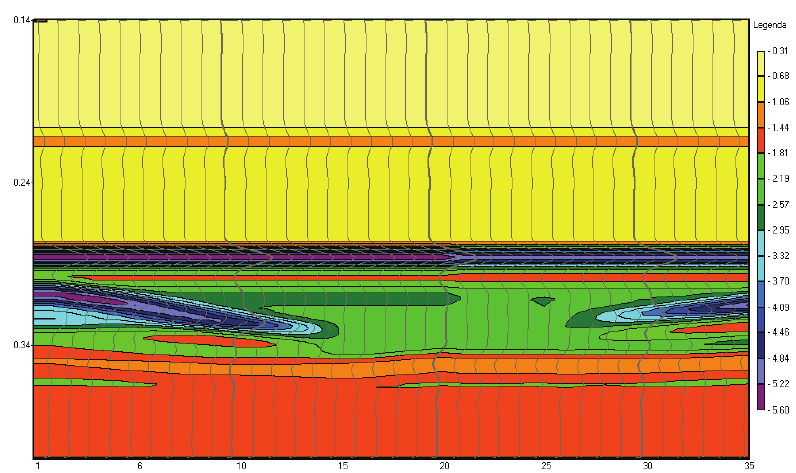
Fig. 1. Simplified seismological model